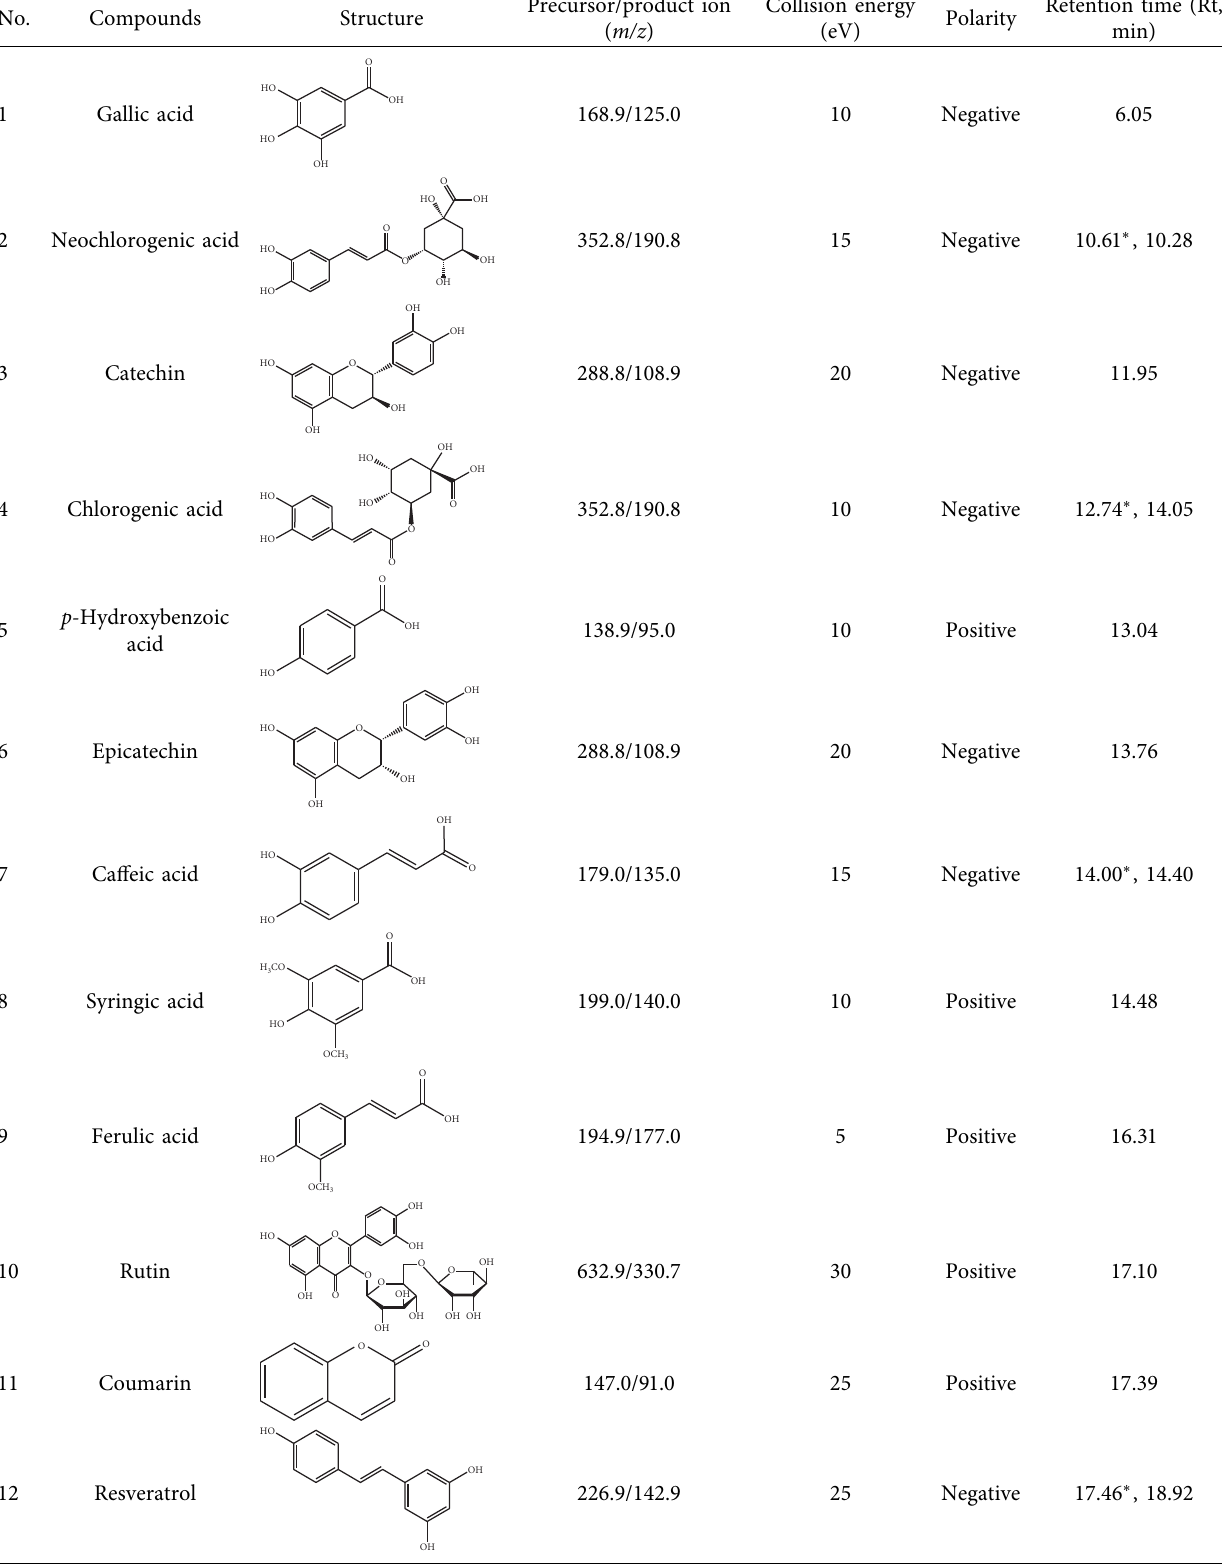
Table 1: Quantitative information and their related mass conditions of